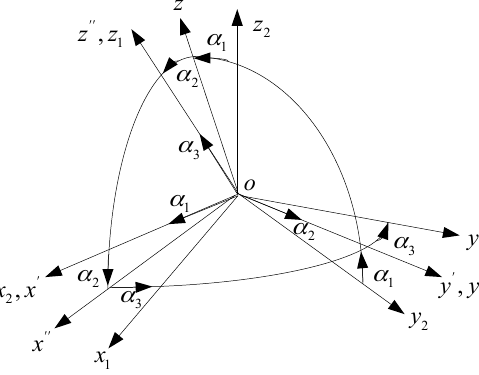
Figure 2. Coordinate rotation of magnetic dipole and magnetic sensor. are extracted from the sensing signals.